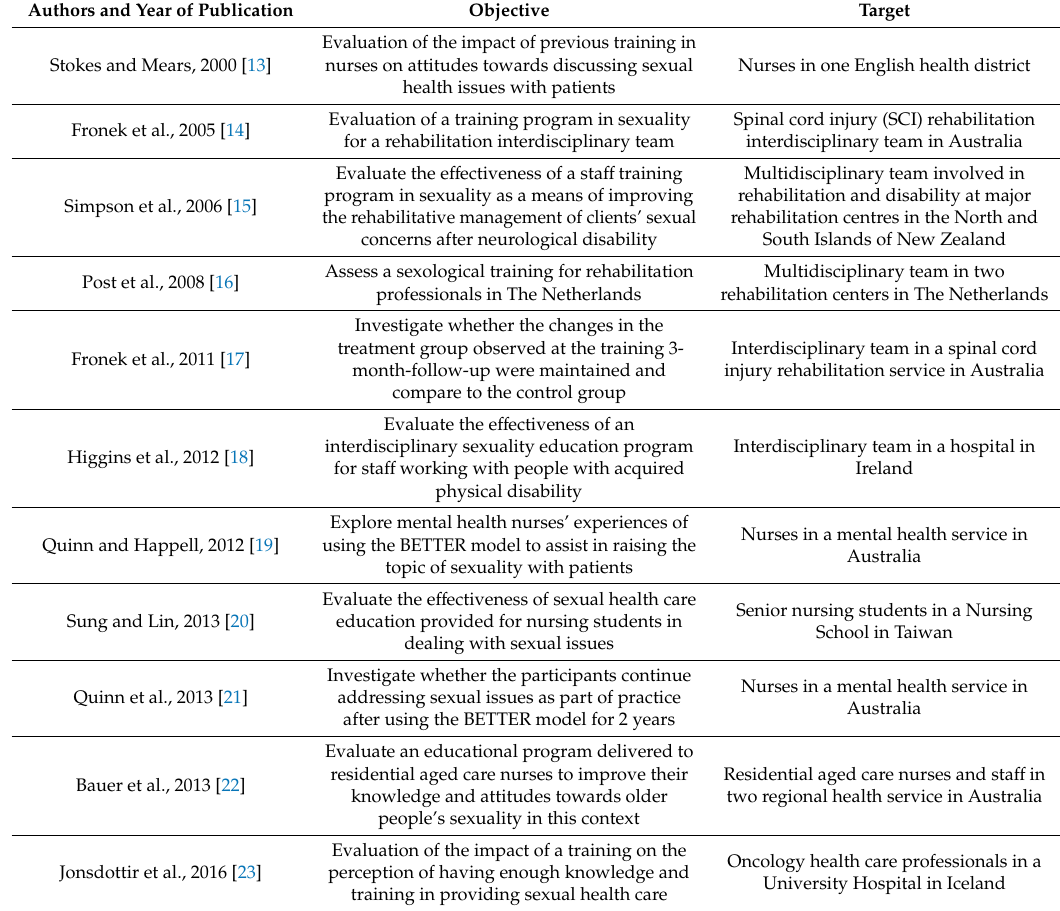
Table 1. Authors, year of publication, objective, and targets of articles selected for the